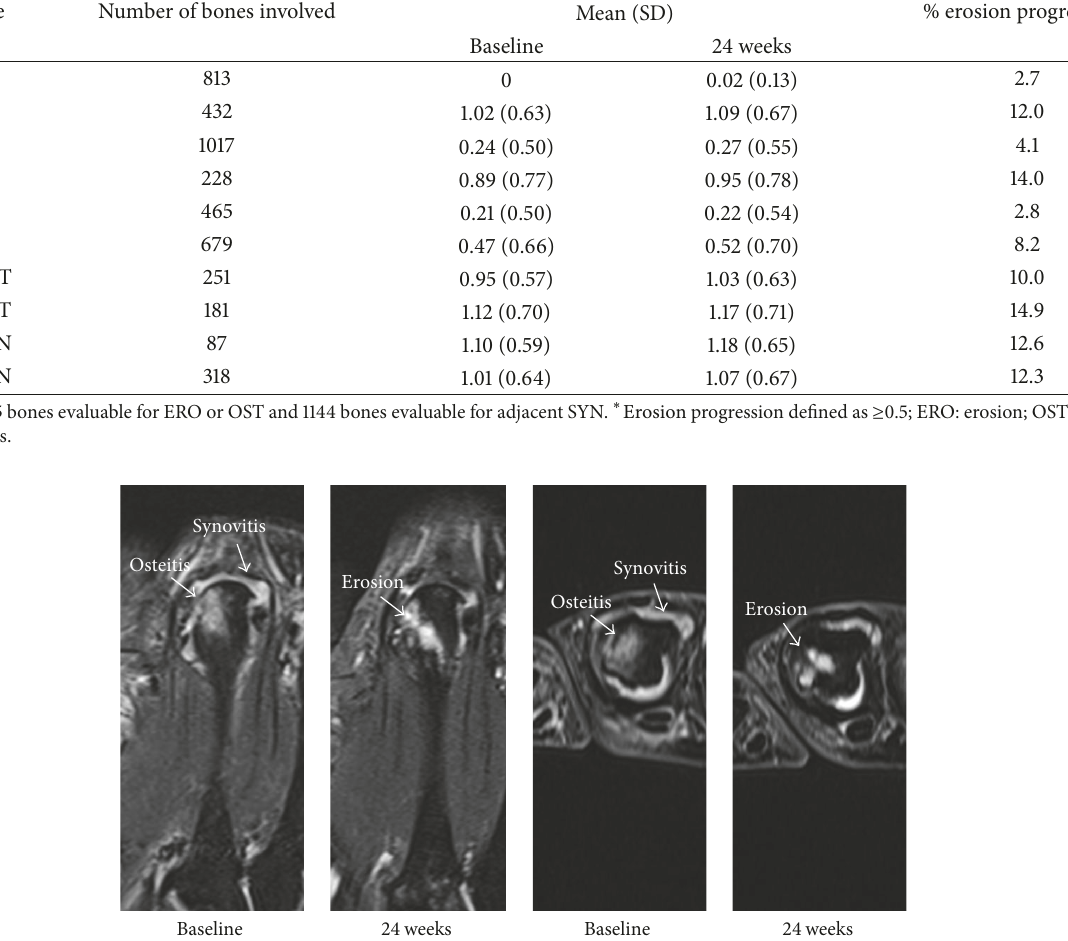
Table 5: Effect of erosion, osteitis, and synovitis at baseline on subsequent progression of erosion. MRI feature